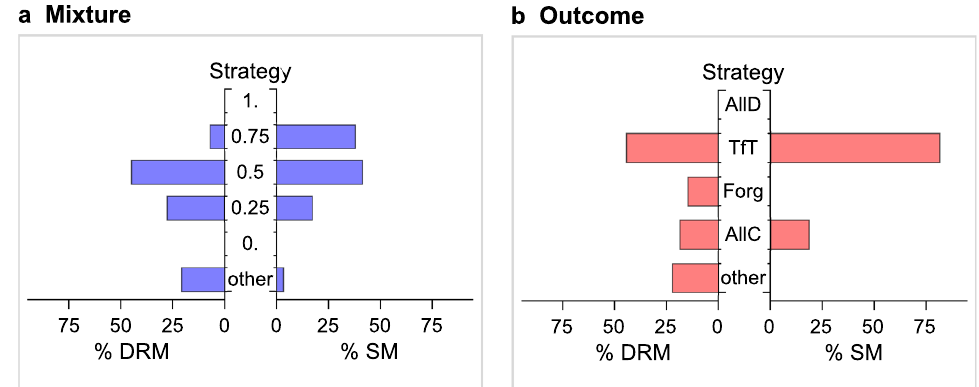
Figure 4. Distribution of Players’ 1 strategies. Players 1 were classified according to their choices in reaction to the information they had received in each treatment. In the Mixture treatments ( n = 29 ), the most frequent strategy was 0.5, that is, subjects who played C only if the observed frequency of cooperation was at least 50%. In the Outcome treatments ( n = 27 ), the most frequent strategy was TfT. This is in accordance with Player 1 choosing (one of his) equilibrium